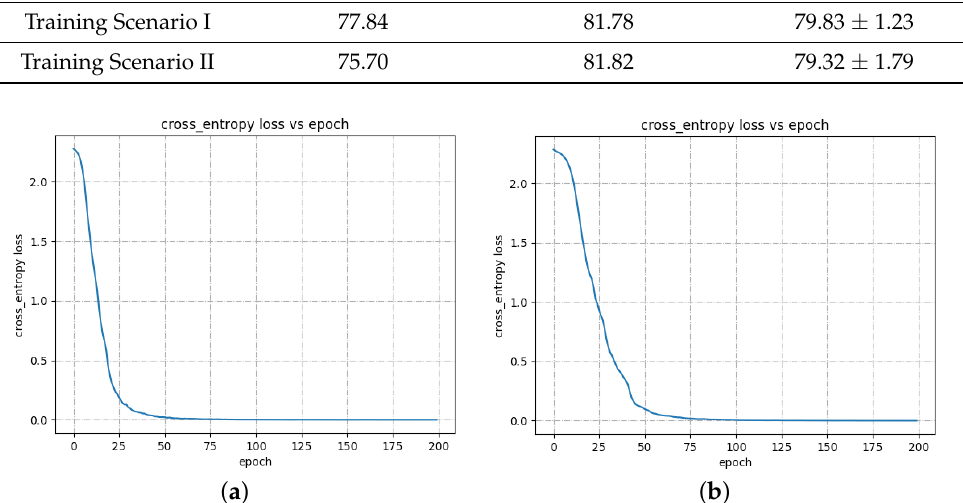
Figure 8. Vertical and horizontal axes denote the classification loss value and the number of iterations for training, respectively. ( a ) Training Scenario I. ( b ) Training Scenario